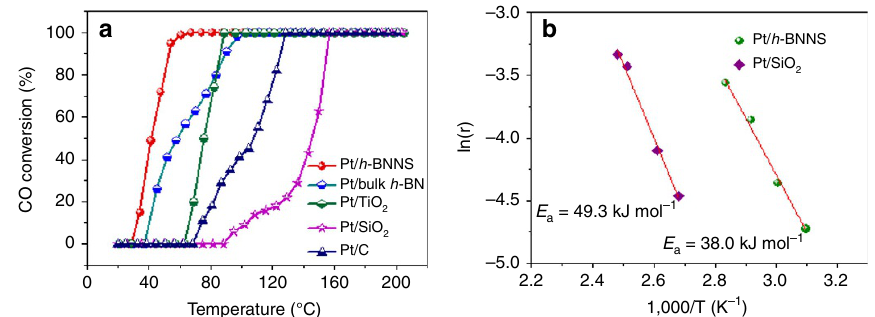
Figure 4 | CO oxidation activity of Pt/ h -BNNS. ( a ) CO oxidation light-off curves for the Pt/ h -BNNS, Pt/bulk h -BN, Pt/TiO 2 , Pt/SiO 2 and Pt/C, m(catalyst) ¼ 30mg, CO flow rate 10mlmin (cid:2) 1 . ( b ) The apparent activation energies ( E a ) of Pt/ h -BNNS and Pt/SiO 2 , m(catalyst) ¼ 5mg, CO flow rate 10mlmin (cid:2) 1